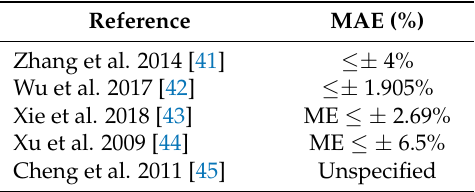
Table 4. MAE/ME of the CC SOC estimation method.